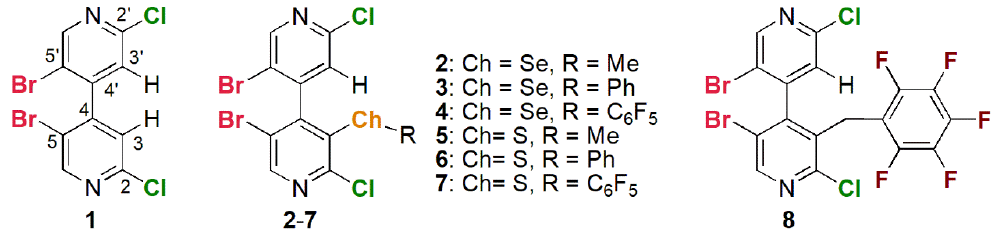
Figure 2. Structures of compounds 1 – 8 .